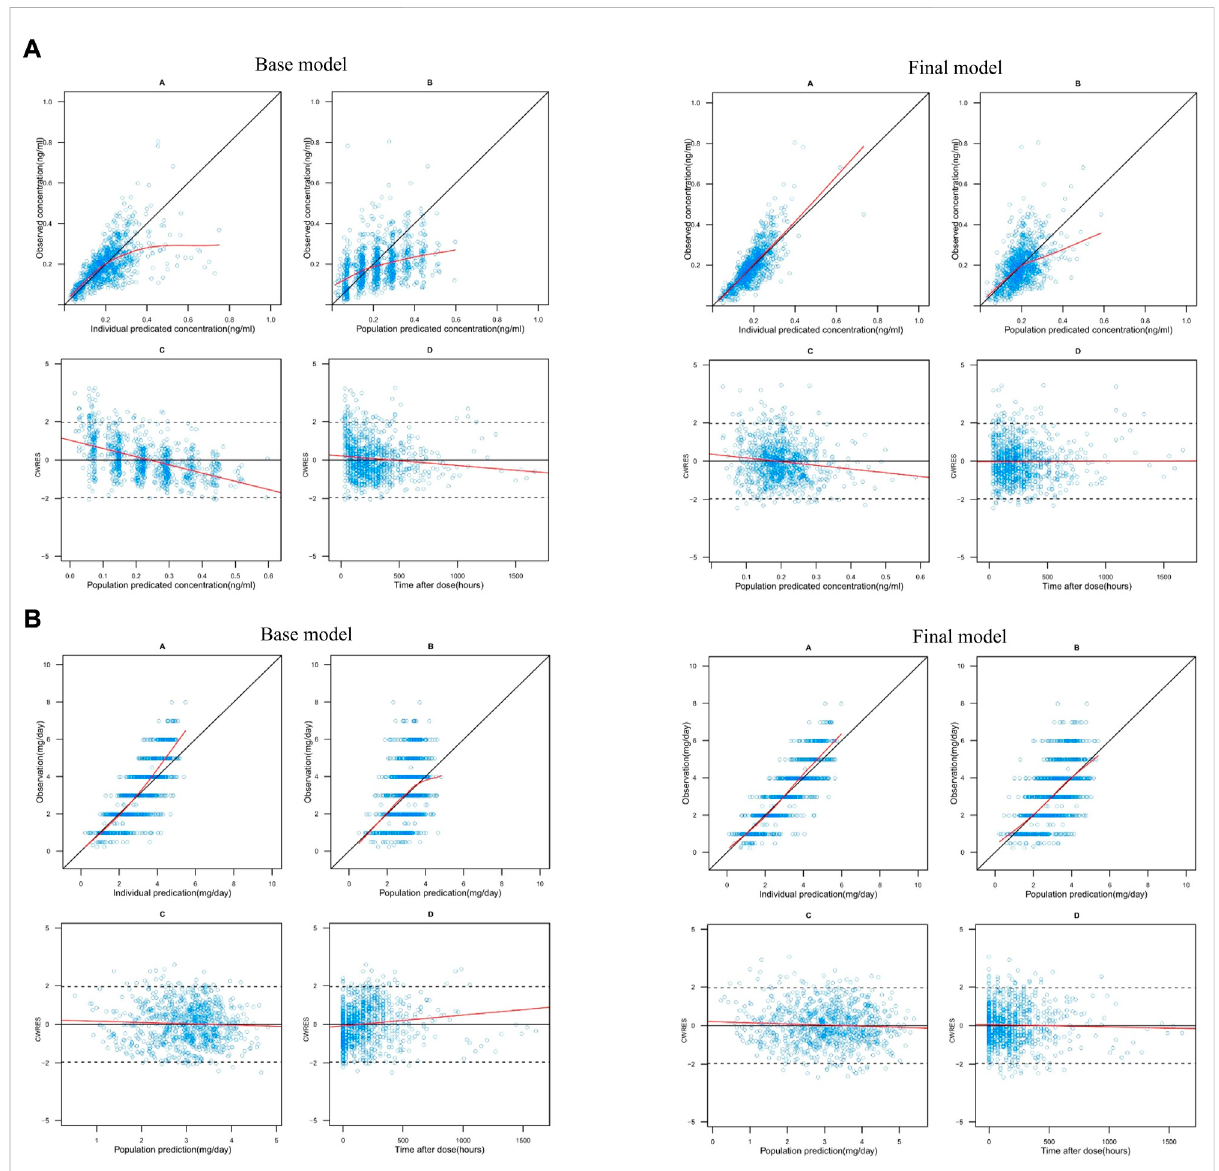
FIGURE 1 (A) Goodness-of- fi tplots forthetheory-basedbaseand fi nalmodel. Ineachmodel:A.observations( y -axis)vs.individualpredictions( x -axis),B. observations ( y -axis) vs. population predictions ( x -axis), C. conditional weighted residuals (CWRES) ( y -axis) vs. population predictions ( x -axis) and D. CWRES ( y -axis) vs. time after dose ( x -axis). In plots A and B, the black solid lines are identity lines. In plots C and D, the black solid and dashed lines represent the y = 0 and y = ±1.96 reference lines, respectively. The red solid lines represent local polynomial regression (lowess) lines. (B) Goodness-of- fi t plots for the MM base and fi nal model. In each model: A. observations ( y -axis) vs. individual predictions ( x -axis), B. observations ( y -axis) vs. population predictions ( x -axis), C. conditional weighted residuals (CWRES) ( y -axis) vs. population predictions ( x -axis) and D. CWRES ( y -axis) vs. time after dose ( x -axis). In plots A and B, the black solid lines are identity lines. In plots C and D, the black solid and dashed lines represent the y = 0 and y = ±1.96 reference lines, respectively. The red solid lines represent local polynomial regression (lowess)